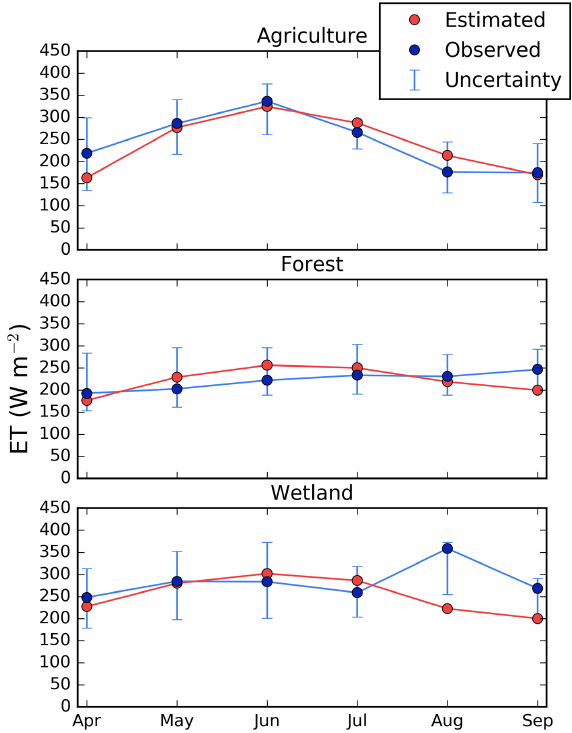
Figure 4. Comparison of TSEB ET estimates in different land cover types. Uncertainty bars limits represent two situations: in the upper limit all the residuals are assigned to the latent heat and in the lower one the residuals are assigned to the sensible heat